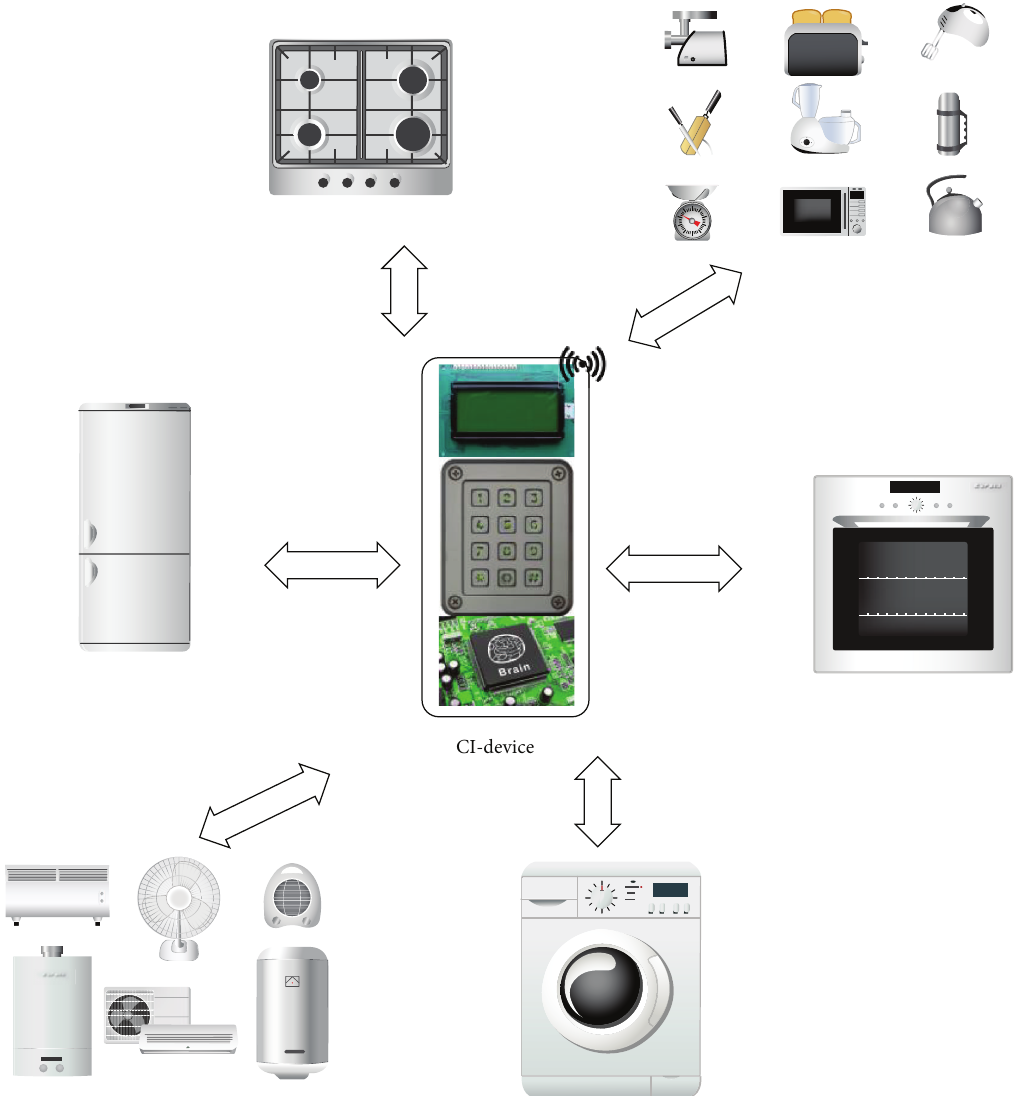
Figure 2: CI-device remotely monitors different household equipment attached with smart